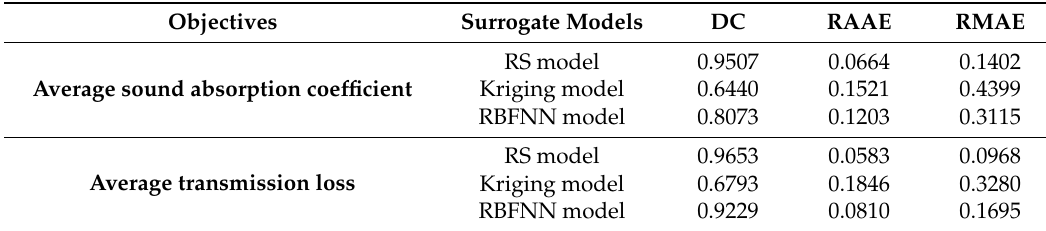
Table 7. Evaluation coefficients of the surrogate